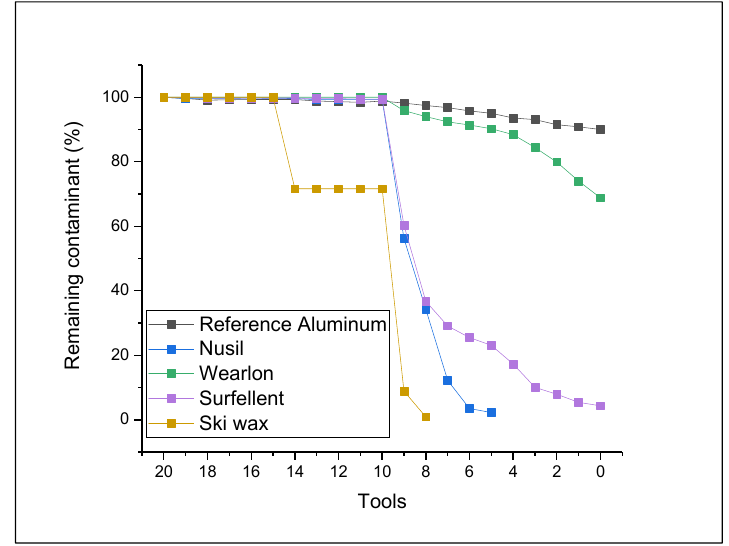
Figure 8. Multi-tool analysis under high-intensity freezing rain. Note: Numbers correspond to the tool used and number of passages during de-icing. Where “20 to 16” represent the broom, “15 to 11” represent the soft polymer blade, “10 to 6” represent the hard polymer blade, “5 to 1” represent the ridged polymer blade, and 0 indicates that ice remained on the surface.